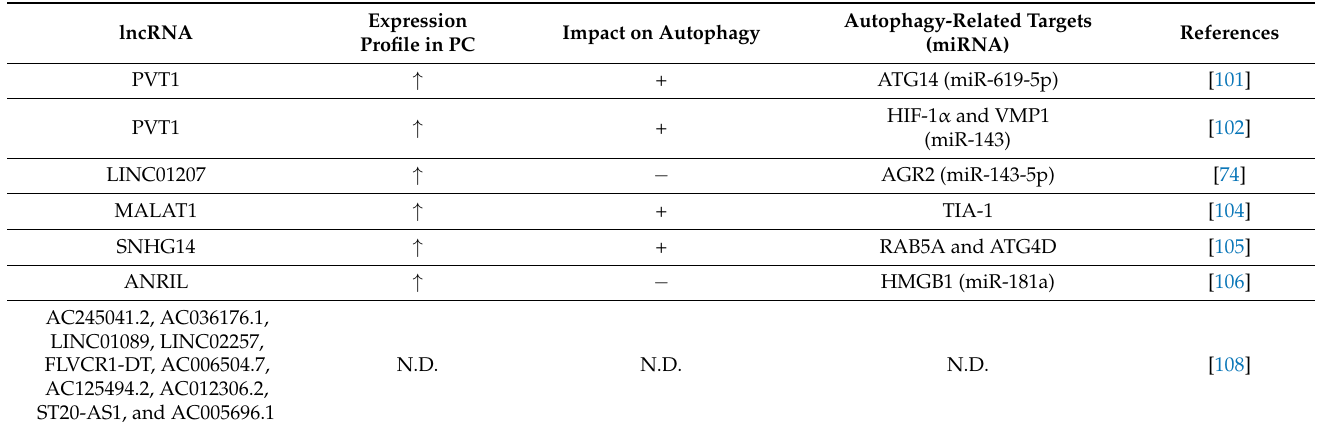
Table 2. Summary of differentially expressed autophagy-related lncRNAs in